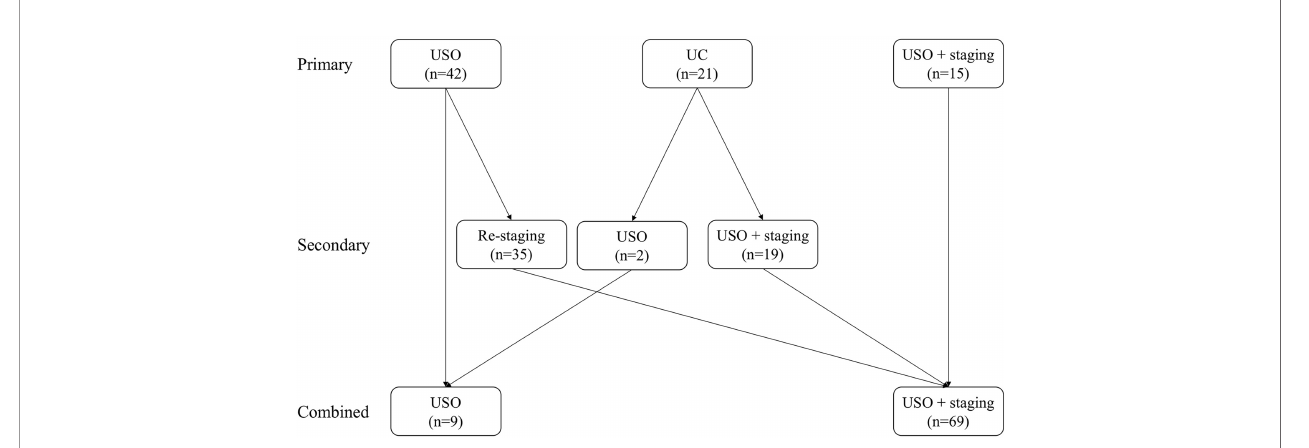
FIGURE 1 | Initial surgical procedures in the FSS group. (USO, unilateral salpingo-oophorectomy; UC, unilateral cystectomy).